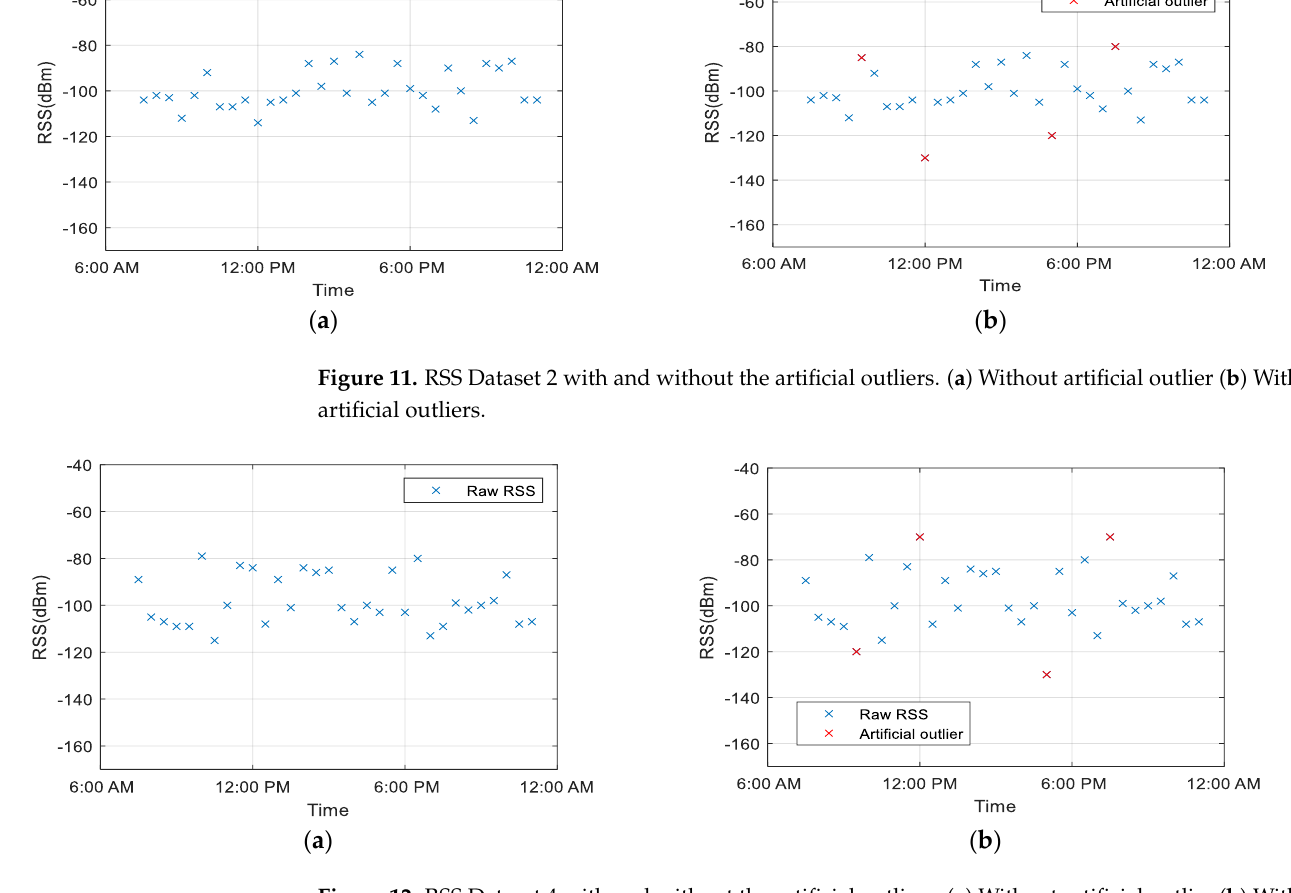
Figure 12. RSS Dataset 4 with and without the artificial outliers. ( a ) Without artificial outlier ( b ) With artificial outliers.